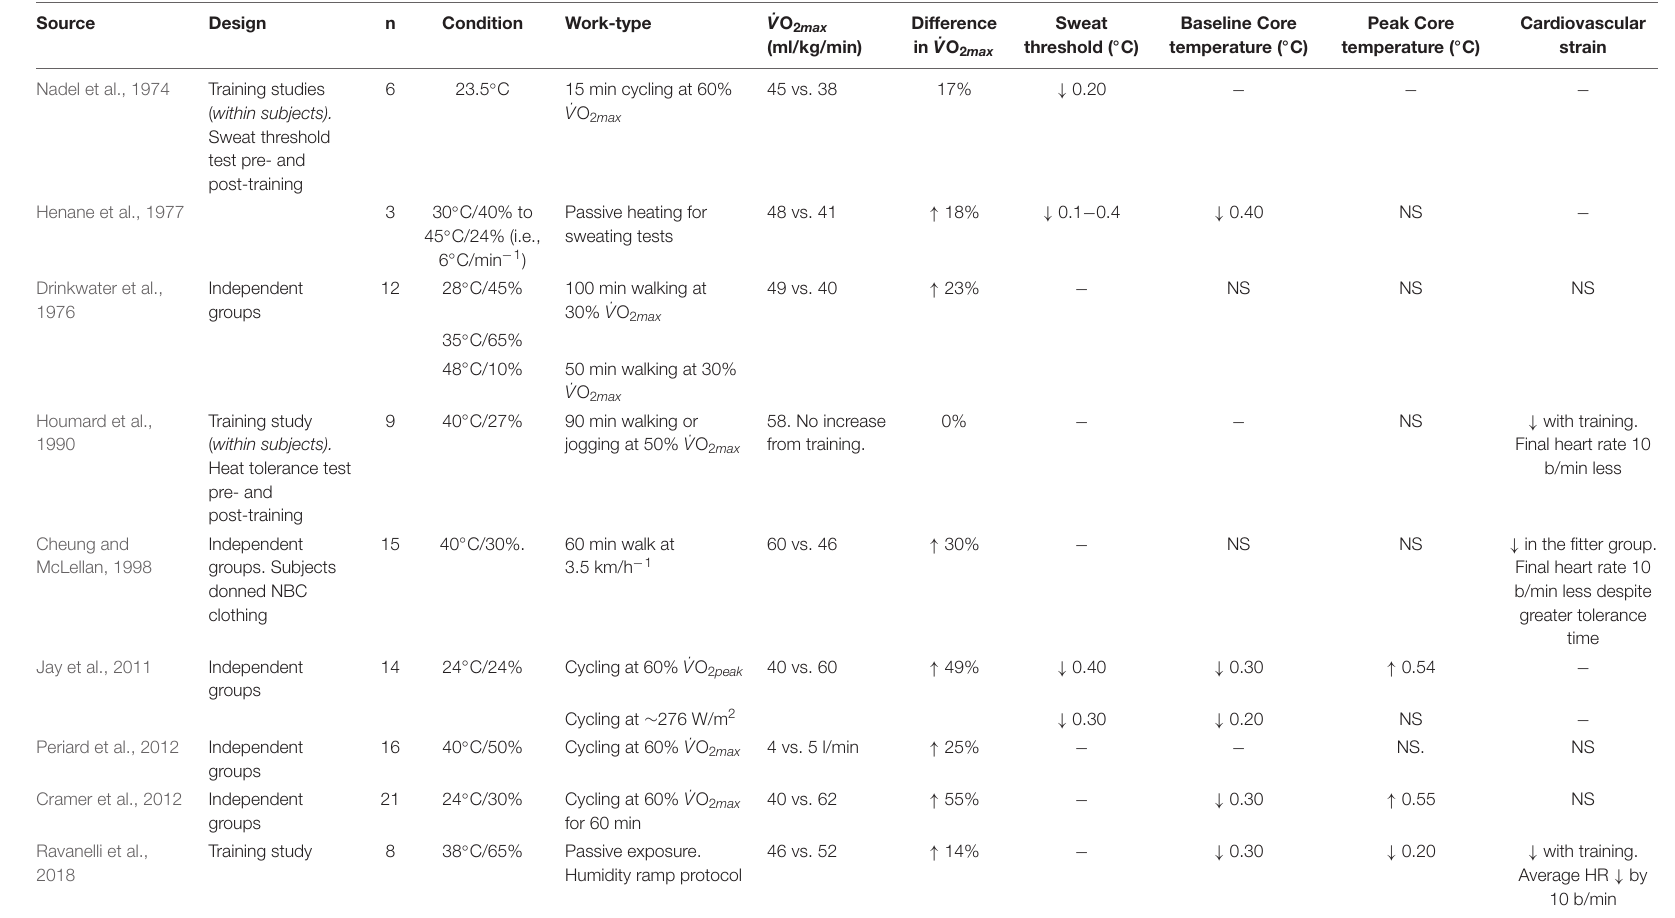
TABLE 5 | Overview of data relating to the effect of aerobic fitness and training on the heat stress response.